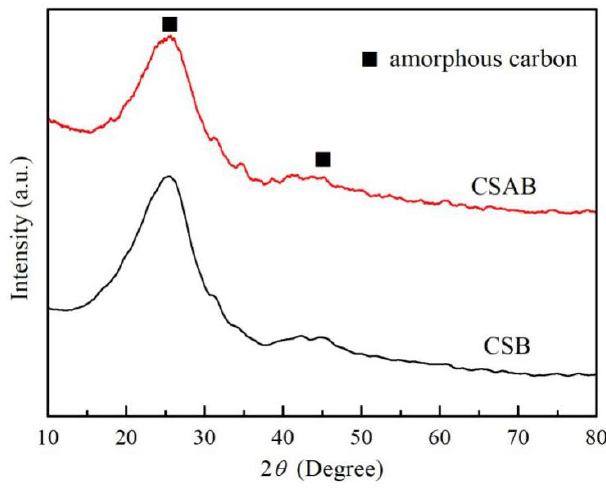
Figure 4. XRD patterns of CSB and CSAB.